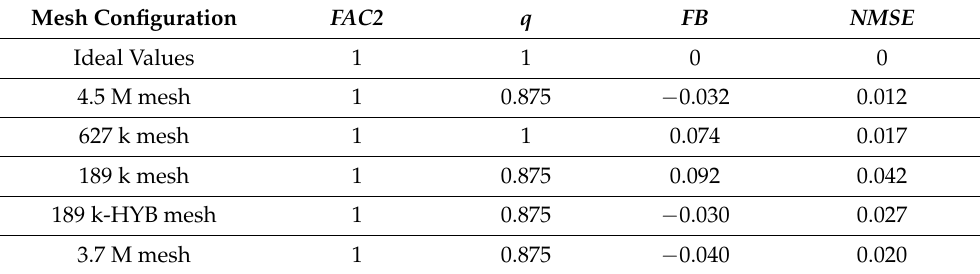
Table 2. Validation metrics for different mesh